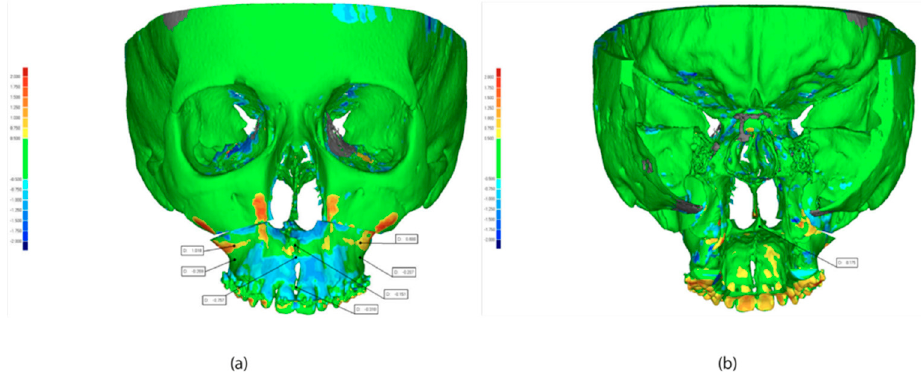
Table 3. p-score of the sign test.